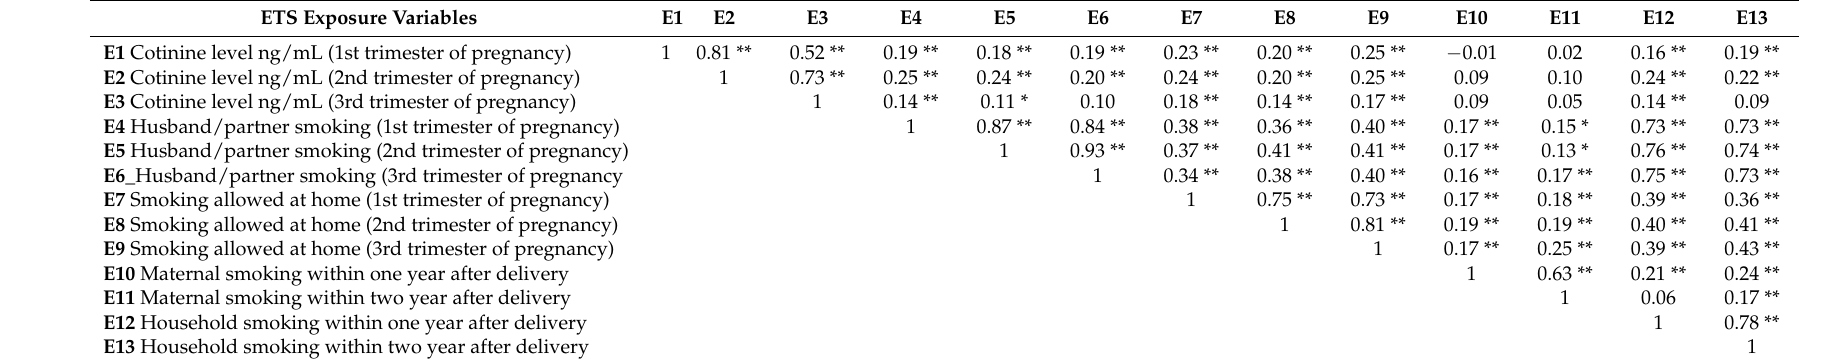
Table 2. Spearman correlation between indicators of exposure to environmental tobacco smoke